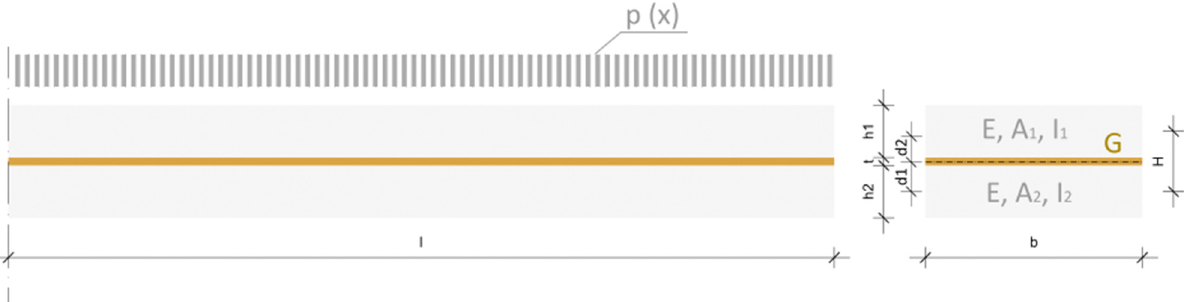
Figure 5. Laminated glass composed of two glass plies and polymeric foil The version of European standards EN 16612 [12] and EN 16613 [31] changes the